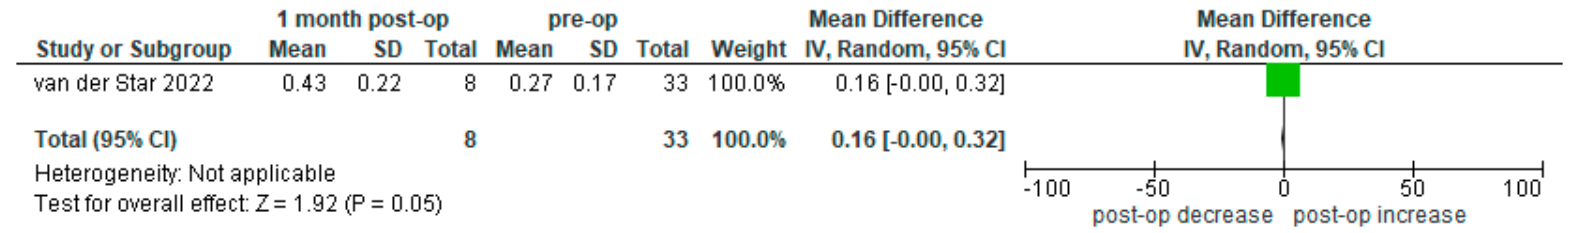
Figure A2. Di ff erence in best contact lens-corrected visual acuity across 1 study [43].